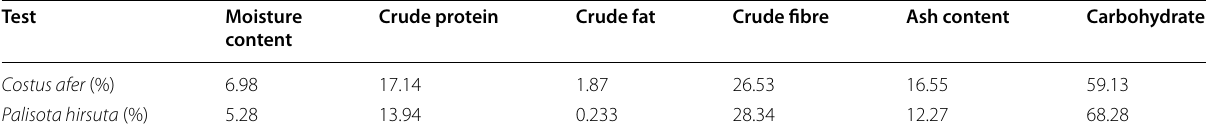
Table 3 Proximate analysis of powdered leaf samples of Costus afer and Palisota hirsuta